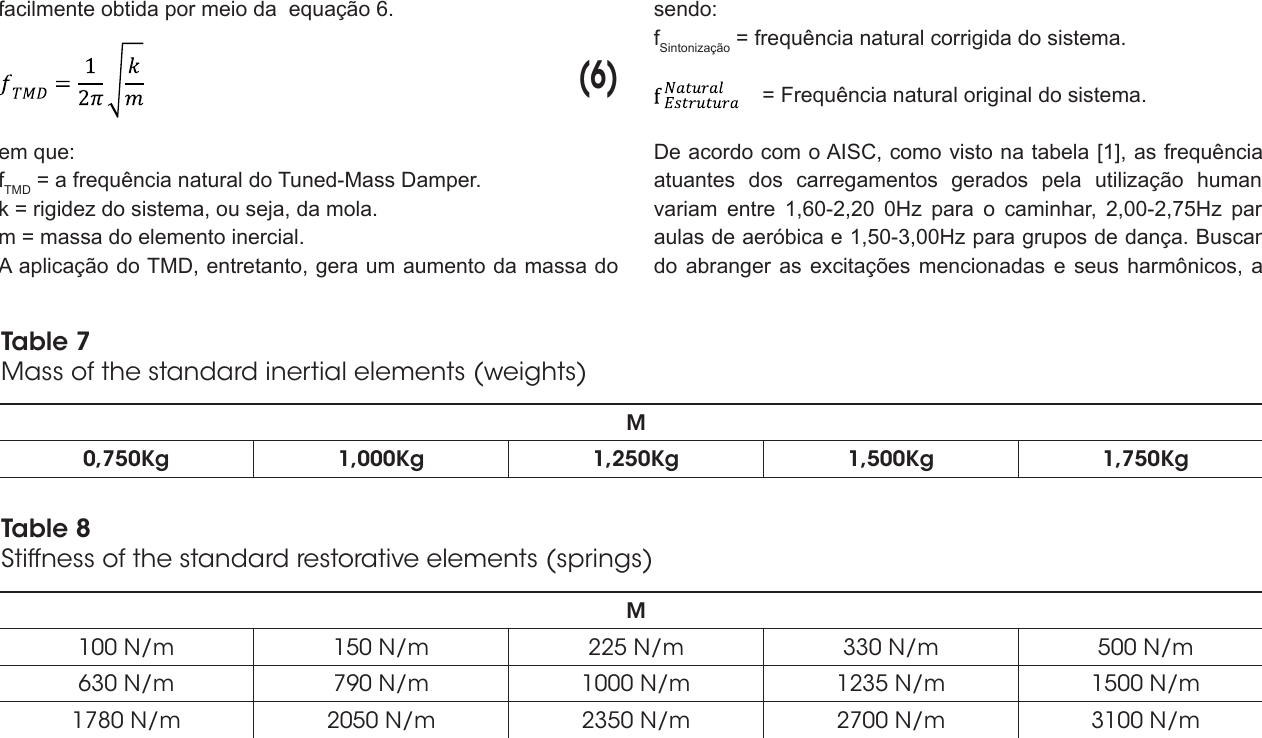
sendo: f = frequência natural corrigida do sistema. Sintonização = Frequência natural original do sistema.